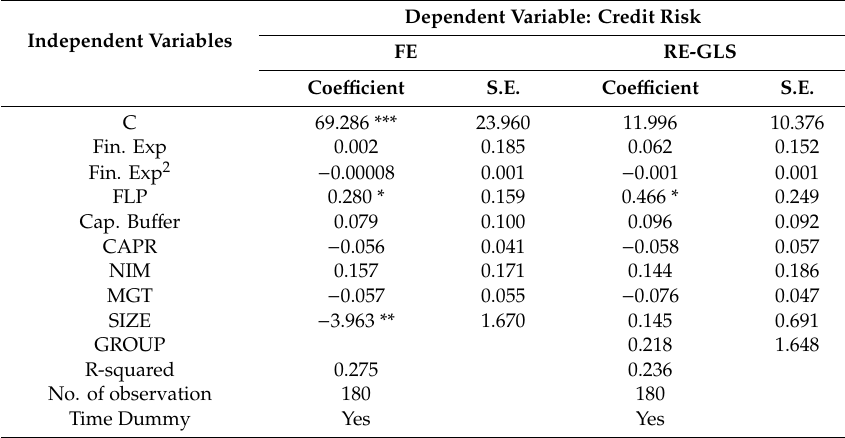
Table 6. Estimated Results with Quadratic